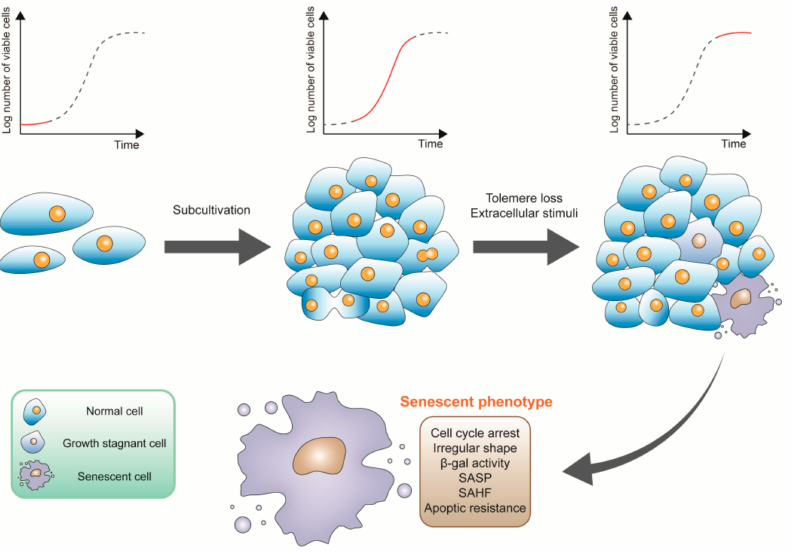
Figure 1. Process and phenotype of senescence. Cell growth curve, senescence process, and characteristics of senescent cells are displayed. SASP; senescence-associated secretory phenotype SAHF, senescence-associated heterochromatin